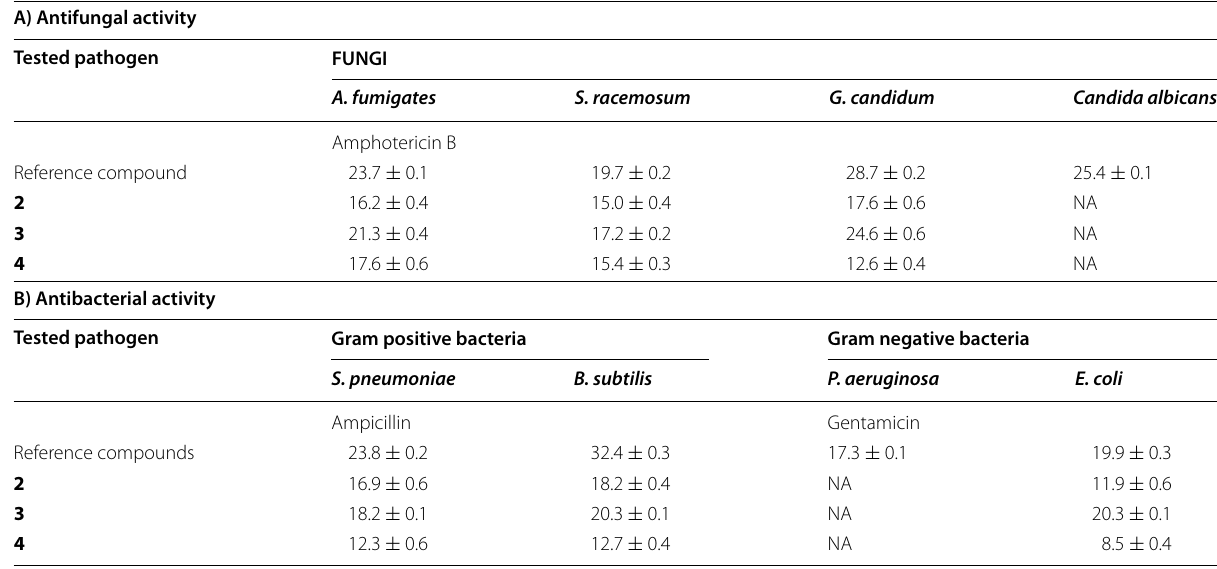
Table 4 Antibacterial and antifungal activity of compounds 2, 3, and 4 (diameter of inhibition zone is given in